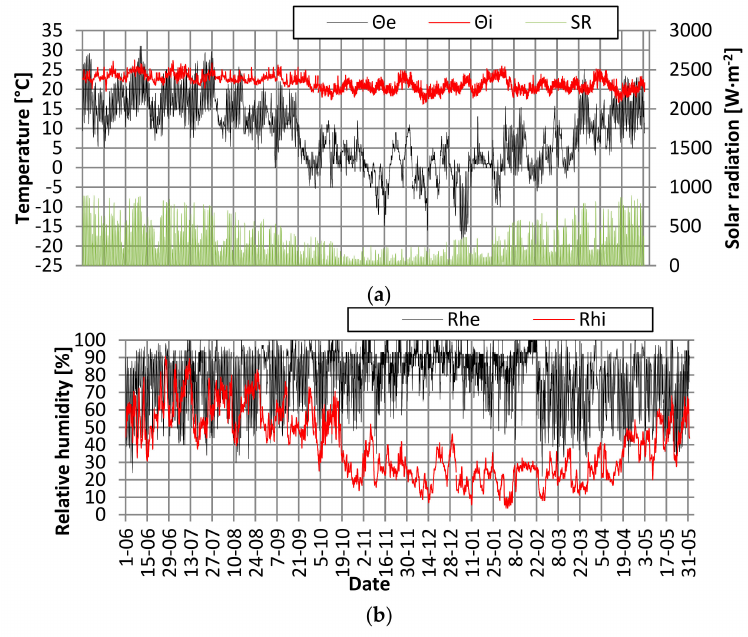
Figure 2. Temperature ( a ) and relative humidity ( b ) of interior and exterior air: SR—solar radiation, Θ Θ e —exterior air temperature, i —interior air temperature, Rh e —exterior air relative humidity, and Rh i —interior air relative humidity.